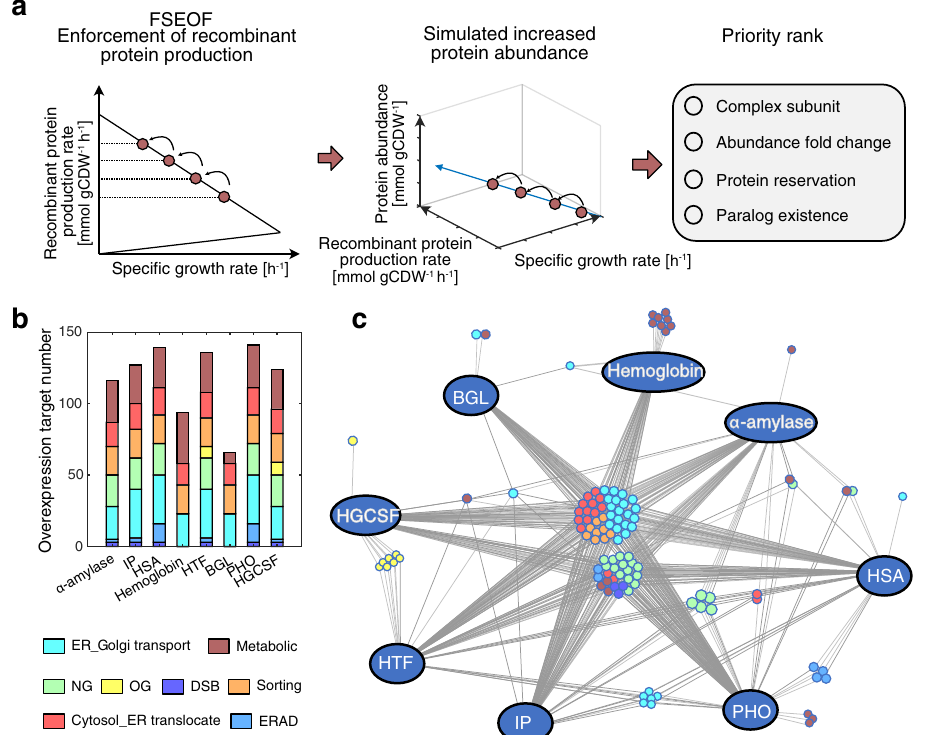
Fig. 5 Prediction and comparison of overexpression targets for improving recombinant protein production. a Adapted FSEOF method for target identi fi cation. Firstly, we reduced the speci fi c growth rate in the simulation. The carbon fl ow towards the growth can be diverted to the recombinant protein production by maximizing the recombinant protein production. Then from the simulated native protein abundances, we can select those proteins with simulated abundance increase resulted from the enforcement of recombinant protein production as initial targets. Priority rank was then performed to further select the targets. Several parameters were considered during this rank such as whether the target is a subunit from an enzyme complex, whether the target protein abundance has changed signi fi cantly, whether the protein is abundant in the cell from the PaxDb, whether the protein contains paralogs. b Pathway overview of the predicted overexpression targets for eight recombinant proteins, respectively. c Comparison of predicted targets for the eight recombinant proteins. Only targets with high priority (higher than 3) were shown in this fi gure. The fi gure is visualized using the DiVenn 78 . Source data are provided as a Source Data fi